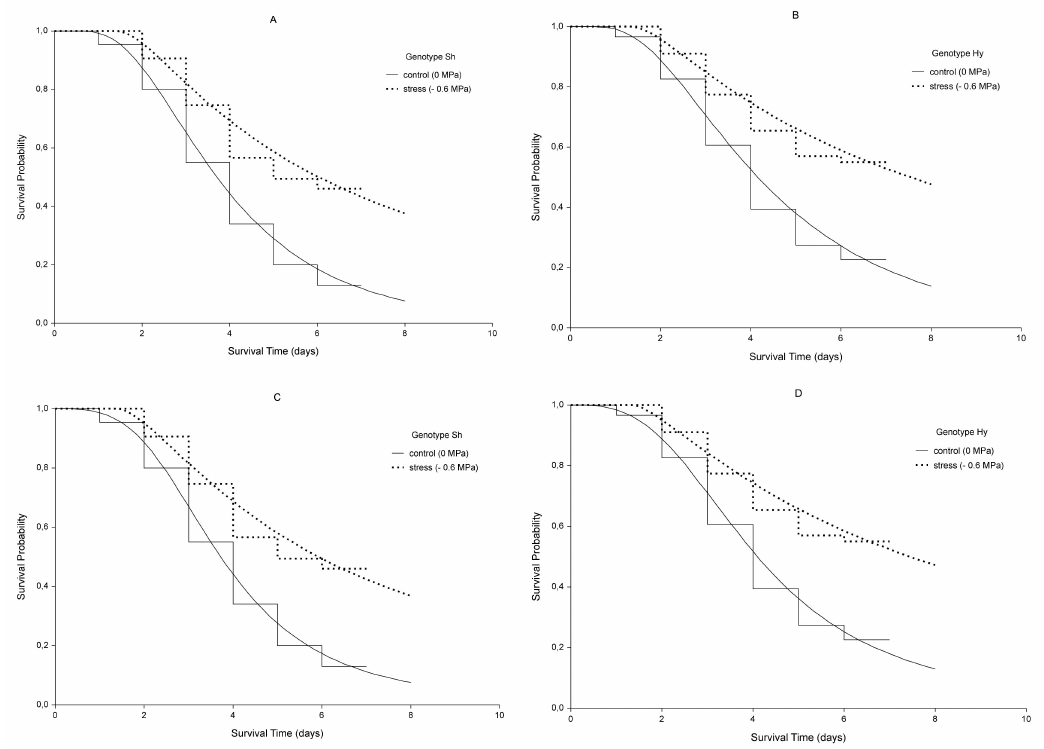
Figure 1. Kaplan-Meier estimates of survival functions (step curves) and AFT log-normal ( A , B ) and log-logistic ( C , D ) model curves (continuous curves) for genotypes Sh and Hy. Dotted lines indicate the stress condition ( ψ = − 0.6 MPa), continuous lines indicate the control ( ψ = 0